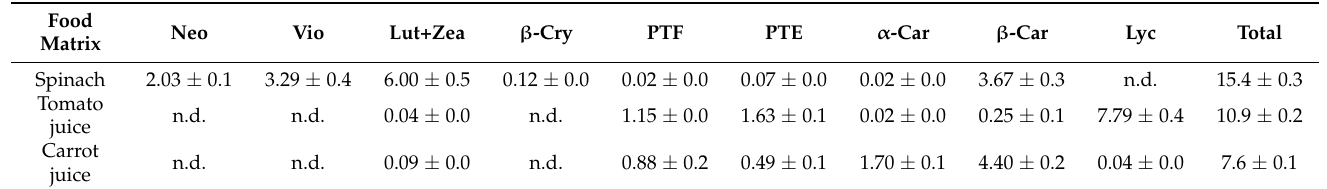
Table 1. Carotenoid content (mg/100 g) for each tested plant food matrix 1 , as determined by HPLC. Food Matrix